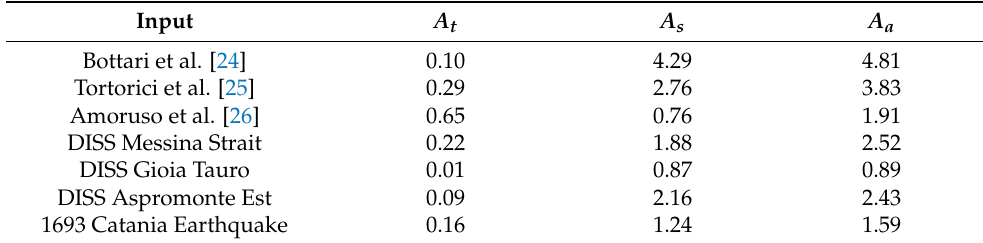
Table 9. Different results for the Ashford et al. [47] model.